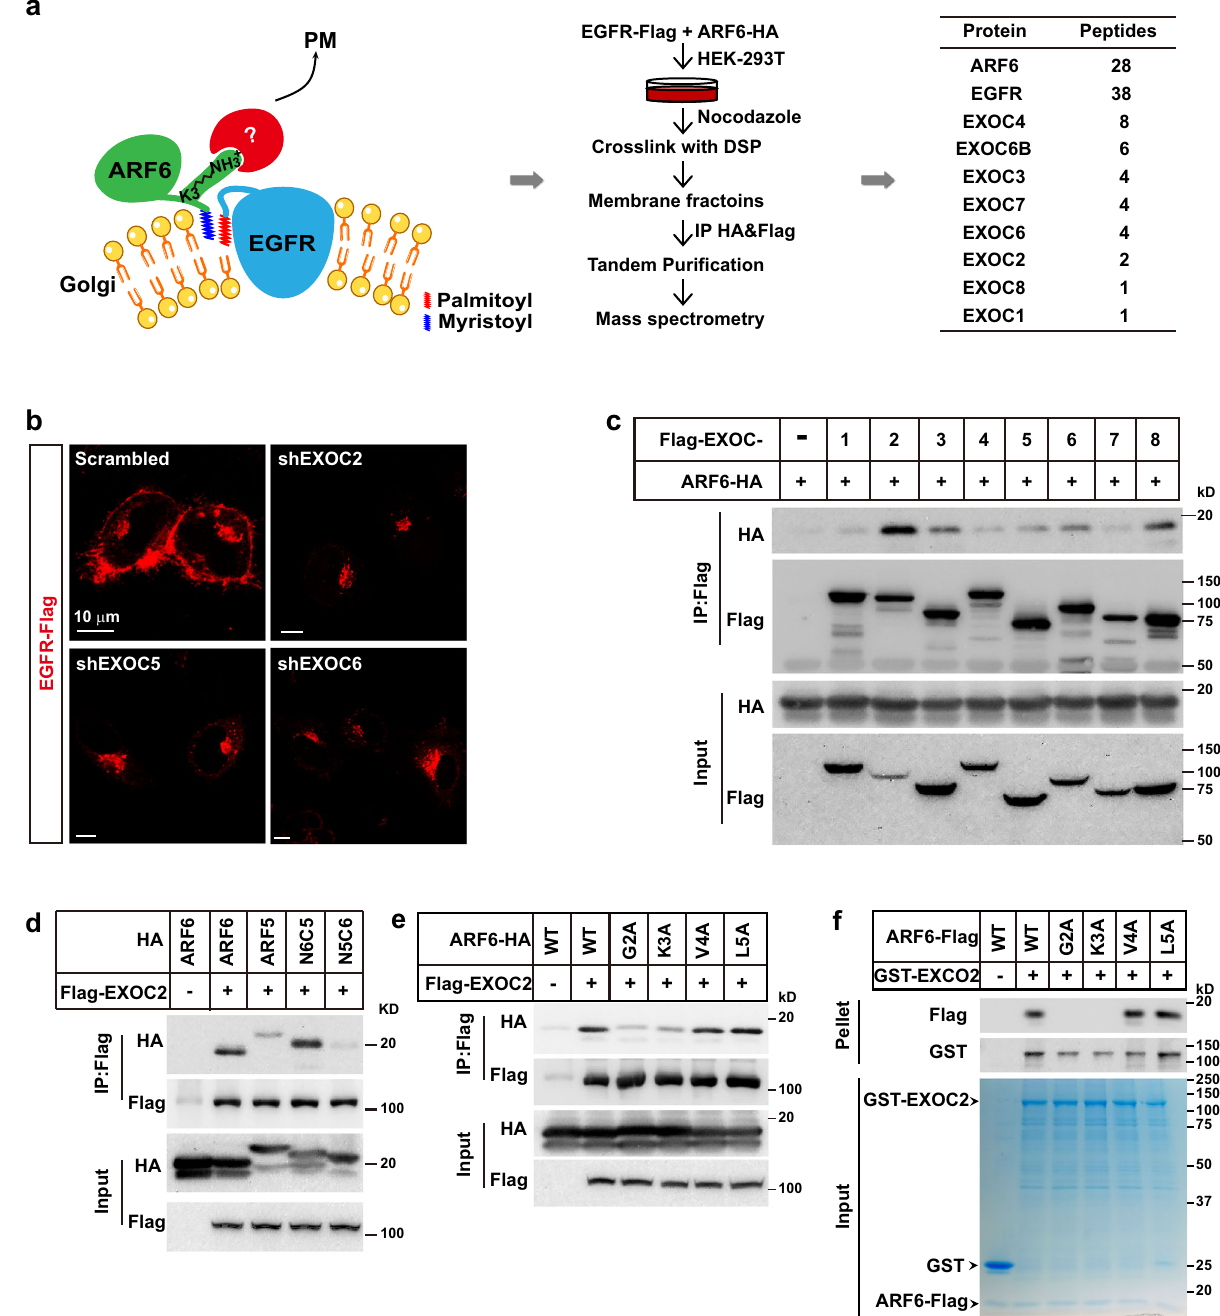
Fig. 4 | Lys3 of ARF6 recruits the exocyst complex to facilitate EGFR budding fromGolgi.a Onday0,HEK293Tcellsweresetupat7×10 5 cellsper10-cmdish.On day 2,cells were transfectedwith EGFR-Flag/pCDH-puroand ARF6-HA/pCDH-puro (4 μ g each). On day 3, cells were treated and subjected to tandem af fi nity pur- i fi cationusinganti-HAandanti-FlagconjugatedbeadsasdescribedinMethods.The elutedfractionwasanalyzedbymassspectrometry. b Onday0,HeLacellswereset up as in Fig. 1c. On day 1, cells were infected with lentivirus expressing shRNAs of EXOC2, EXOC5,orEXOC6onapLL3.7 vector.Onday 3, cellsweretransfected with EGFR-Flag/pCDH-puro. On day 4, cells were harvested for immunostaining. Scale bar,10 μ m. c HEK293TcellsweresetupandtransfectedwithARF6-HA/pCDH-puro andeachoftheFlag-taggedsubunitsoftheExocystcomplexonapcDNA3.3vector. On day 3, cells were harvested for immunoprecipitation using anti-Flag M2 beads. The input and pellet fractions were subjected to western blot using indicated antibodies. d HEK293T cells were co-transfected with Flag-EXOC2 and HA-tagged